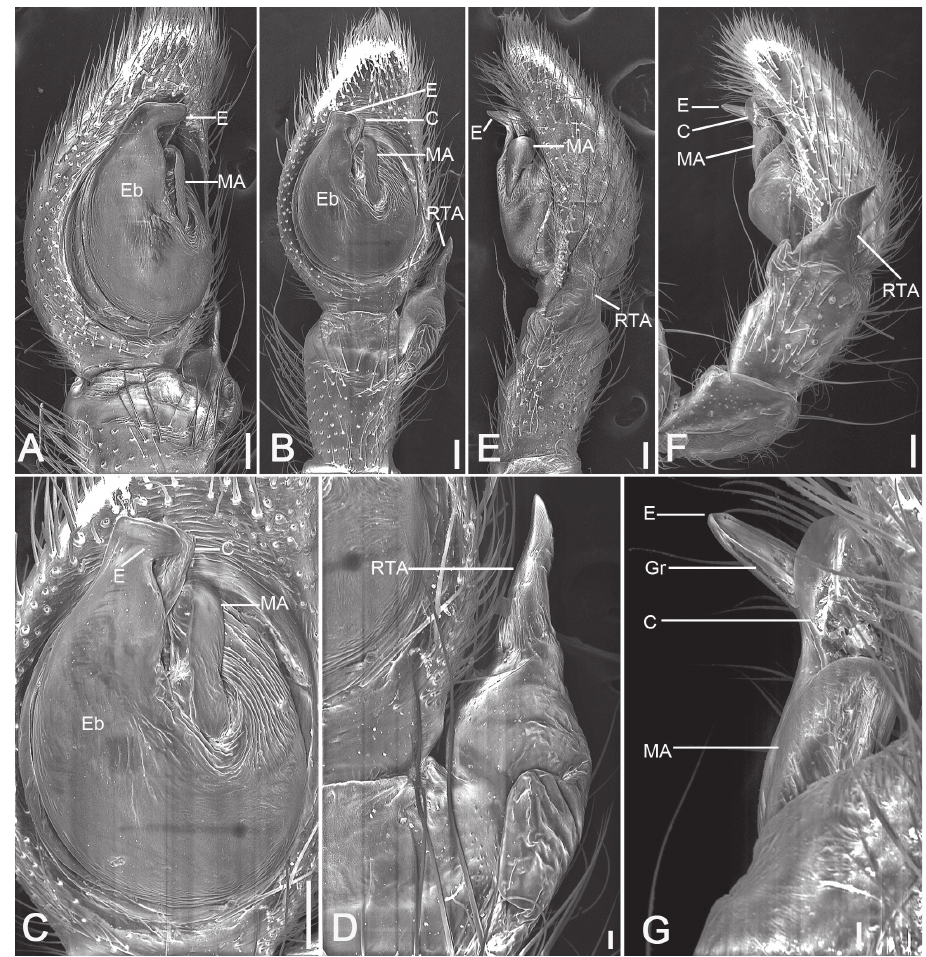
Figure 2. SEM micrographs of Angaeus xieluae sp. nov. male palp (holotype). A prolatero-ventral view B ventral view C same, details of bulb D same, details of retrolateral tibial apophysis E retrolateral view F retrolateral view, slightly dorsal G same, details of embolus. Abbreviations: C – conductor, E – embolus, Eb – base of the embolus, Gr – groove, MA – median apophysis, RTA – retrolateral tibial apophysis. Scale bars: 0.1 mm ( A–C, E, F ), 20 μm ( D, G